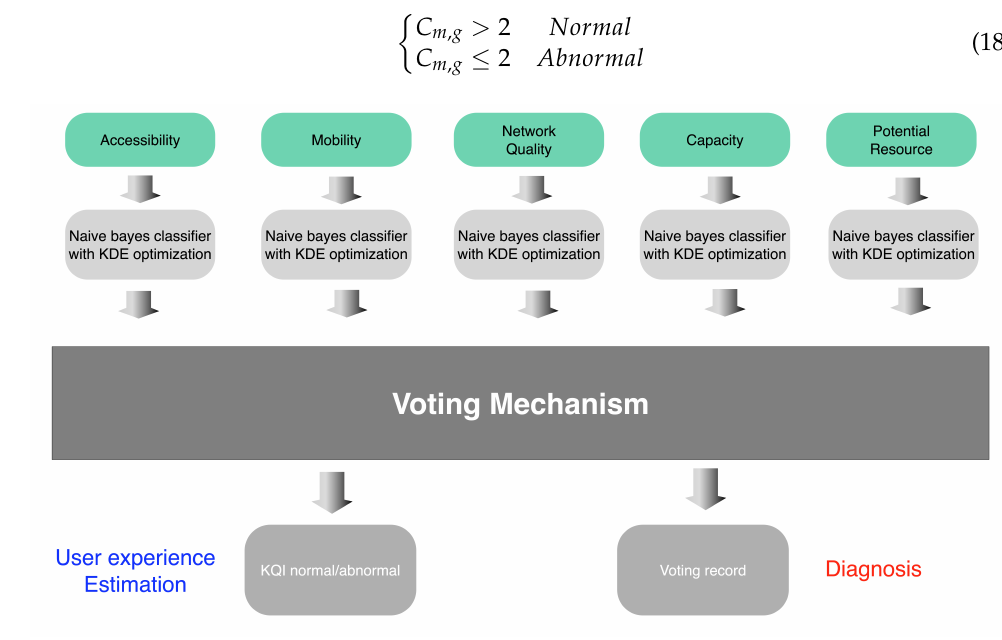
Figure 6. Voting mechanism.